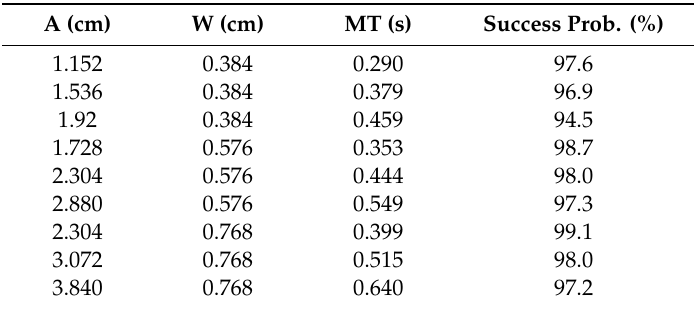
Table 1. Experimental data on Tunnel Traveling Task (from